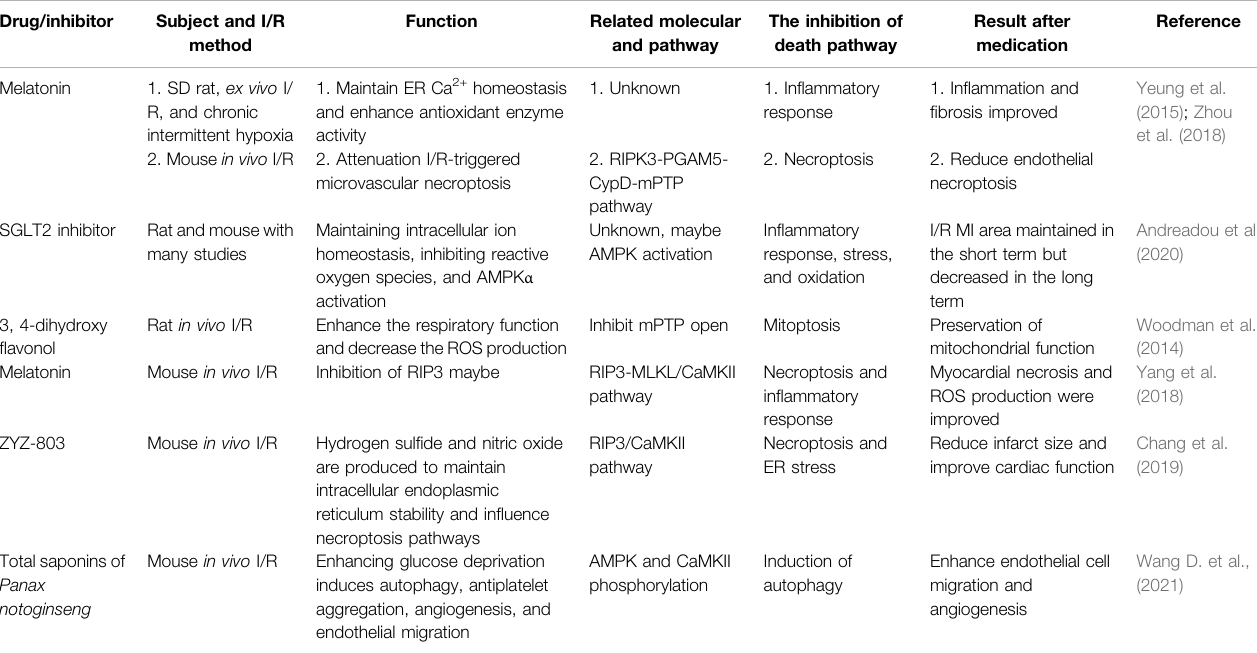
TABLE 3 | Drugs or inhibitors affecting CaMKII-related pathways in